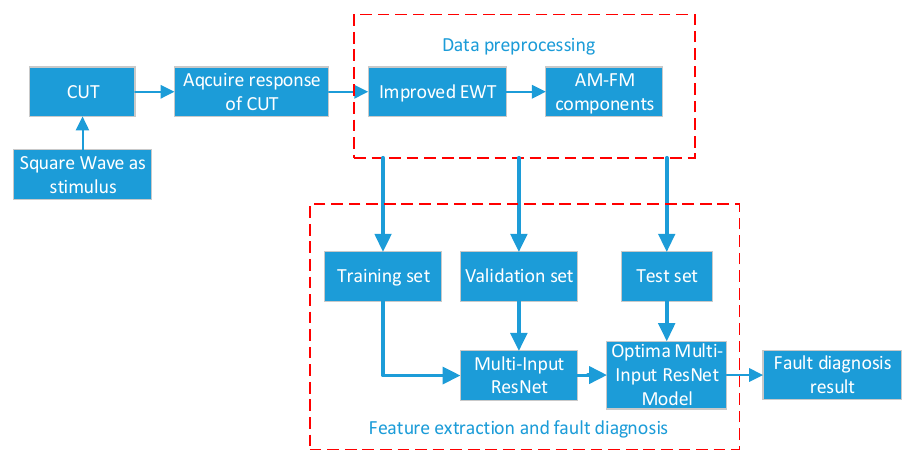
Figure 1. Framework of the proposed method.